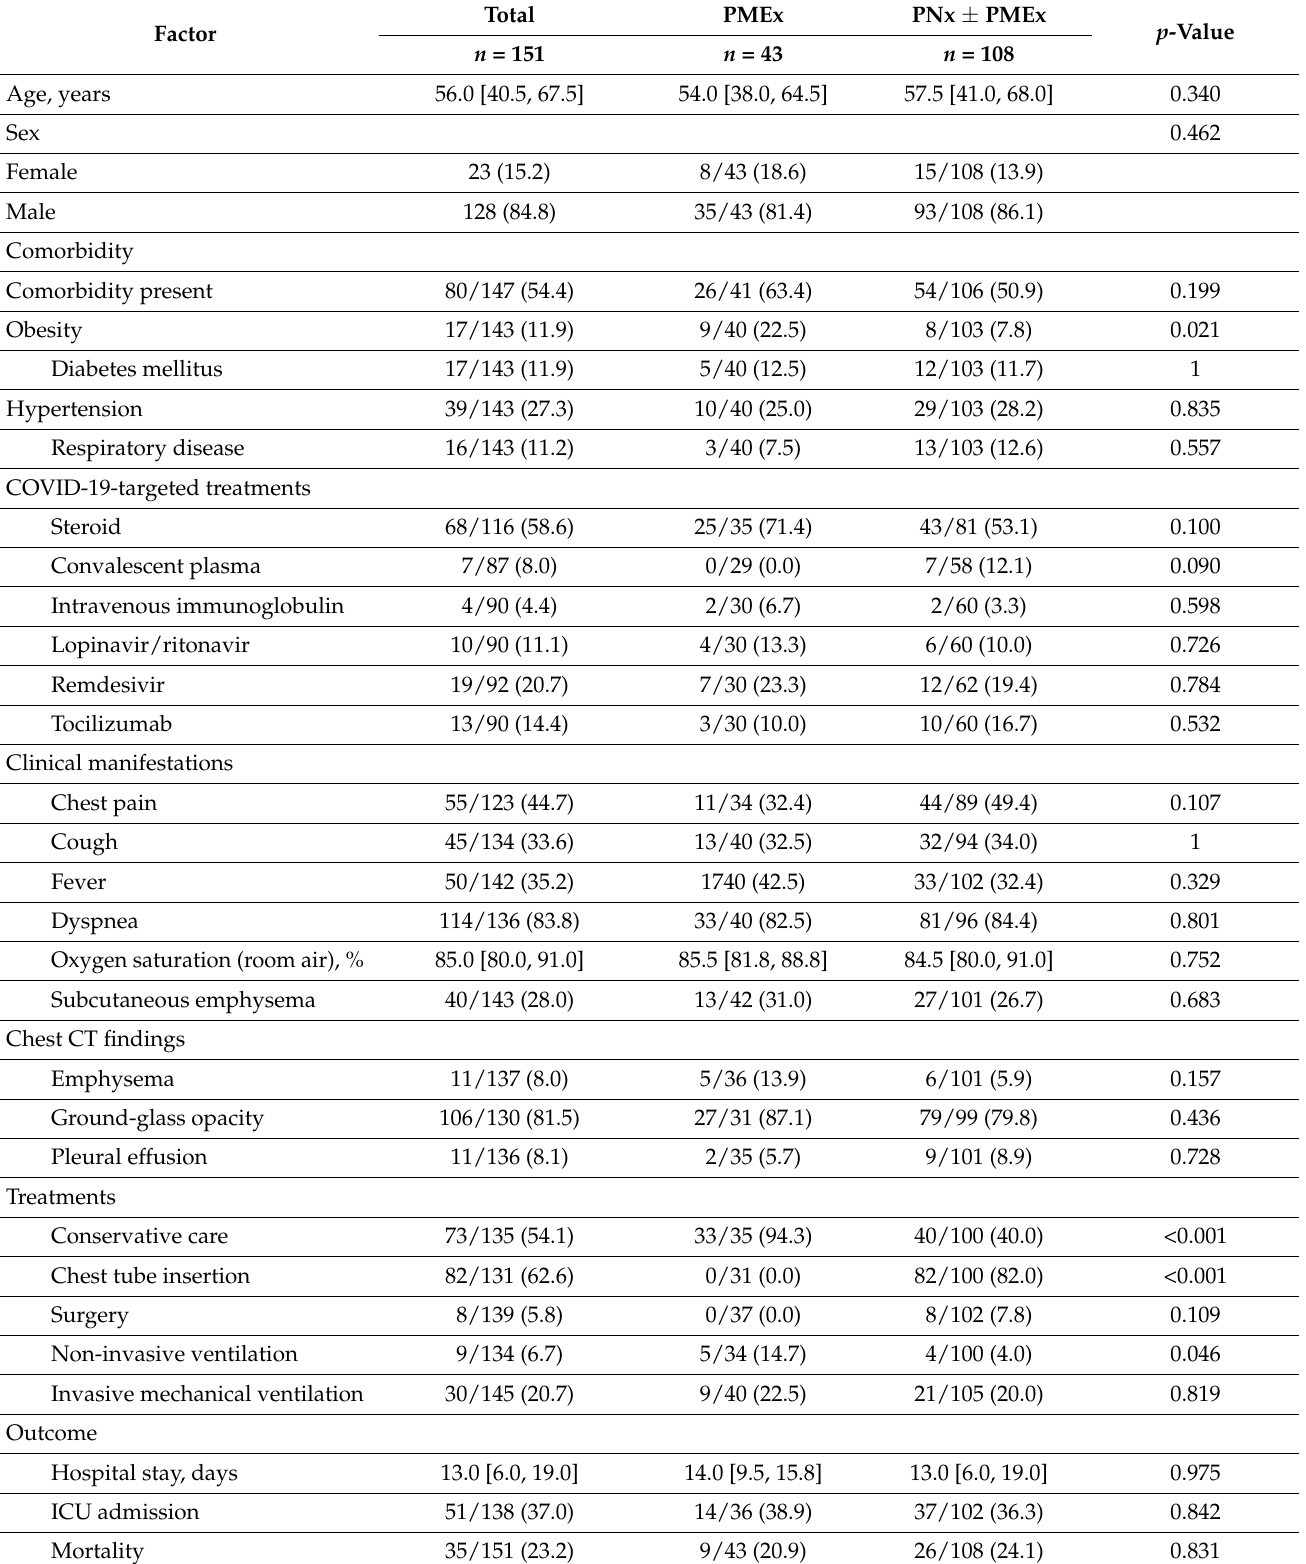
Table 1. Clinical characteristics and outcomes of patients according to the type of